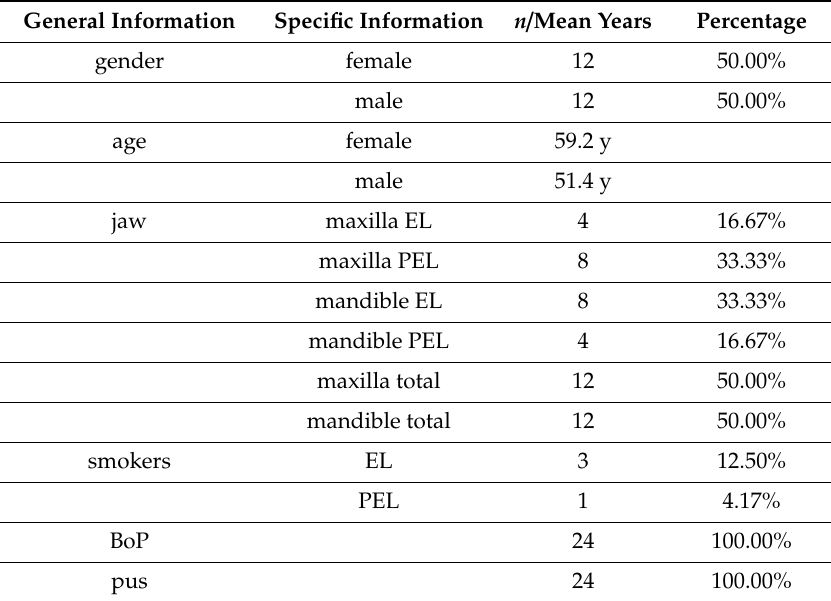
Table 1. Qualitative baseline data indicating homogenous